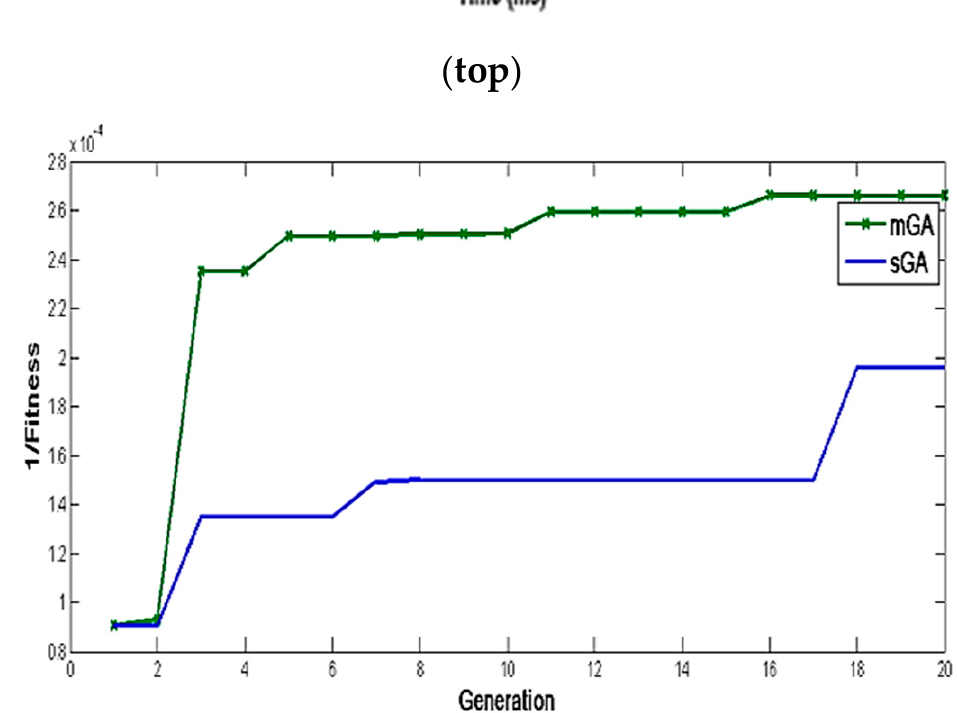
Figure 5. ( Top ) Surge—position control; ( bottom ) improved GA (mGA) versus standard GA (sGA) fitness functions.